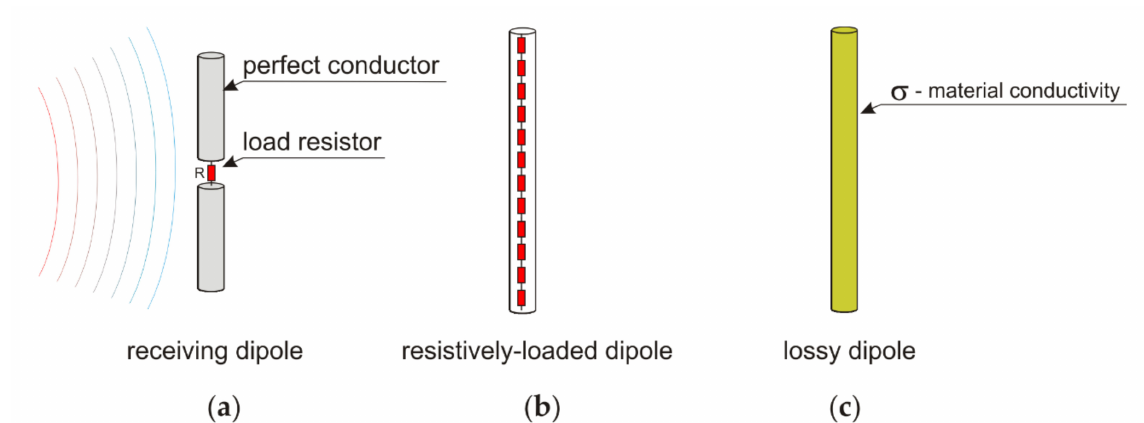
Figure 4. The evolution of the shielding element concept, from loaded receiving dipole to lossy dipole: ( a )—dipole loaded with single resistor, ( b )—dipole loaded with set of resistors, ( c )—dipole made of lossy material.